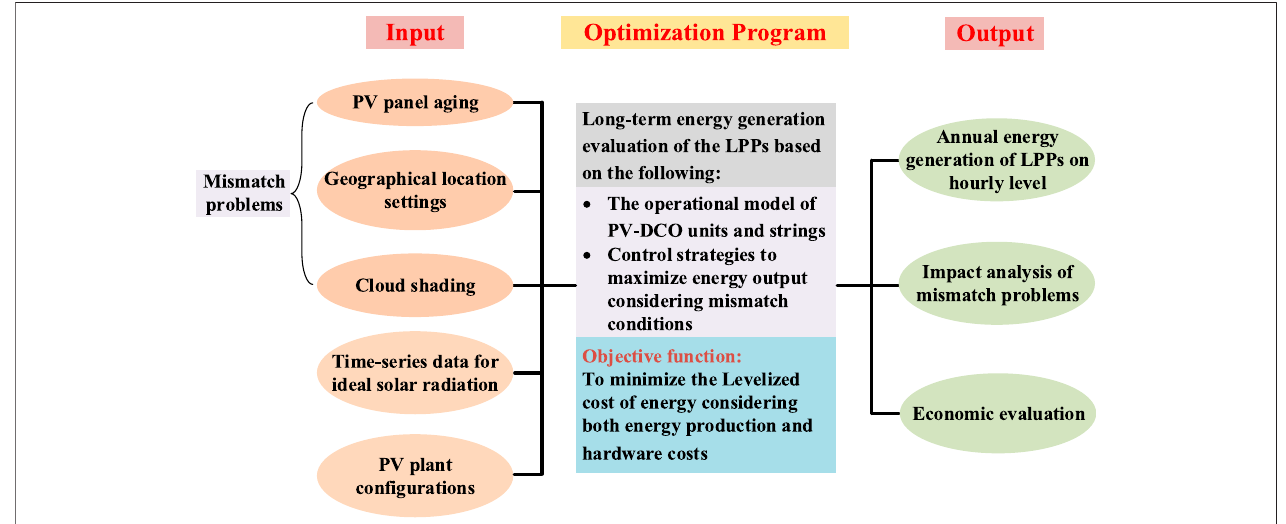
FIGURE 5 | Framework for static modeling of long-term energy generation evaluation in